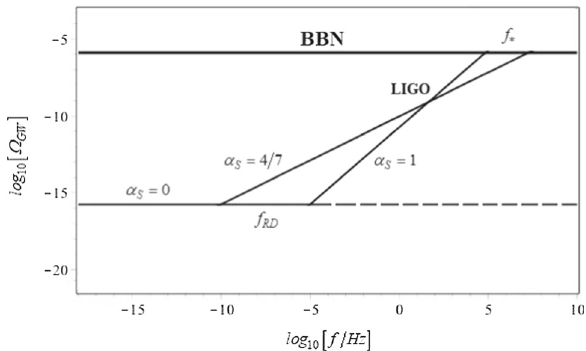
Fig. 2 The spectra of relic gravitational waves (cid:17) GW = (cid:17) GW ( f ) on a logarithmic scale with the BBN constraint and LIGO bound for the stiff energy state parameter 3 / 5 ≤ w S ≤ 1 (4 / 7 ≤ α S ≤ 1) and without the SD stage for w = 1 / 3 ( α S =